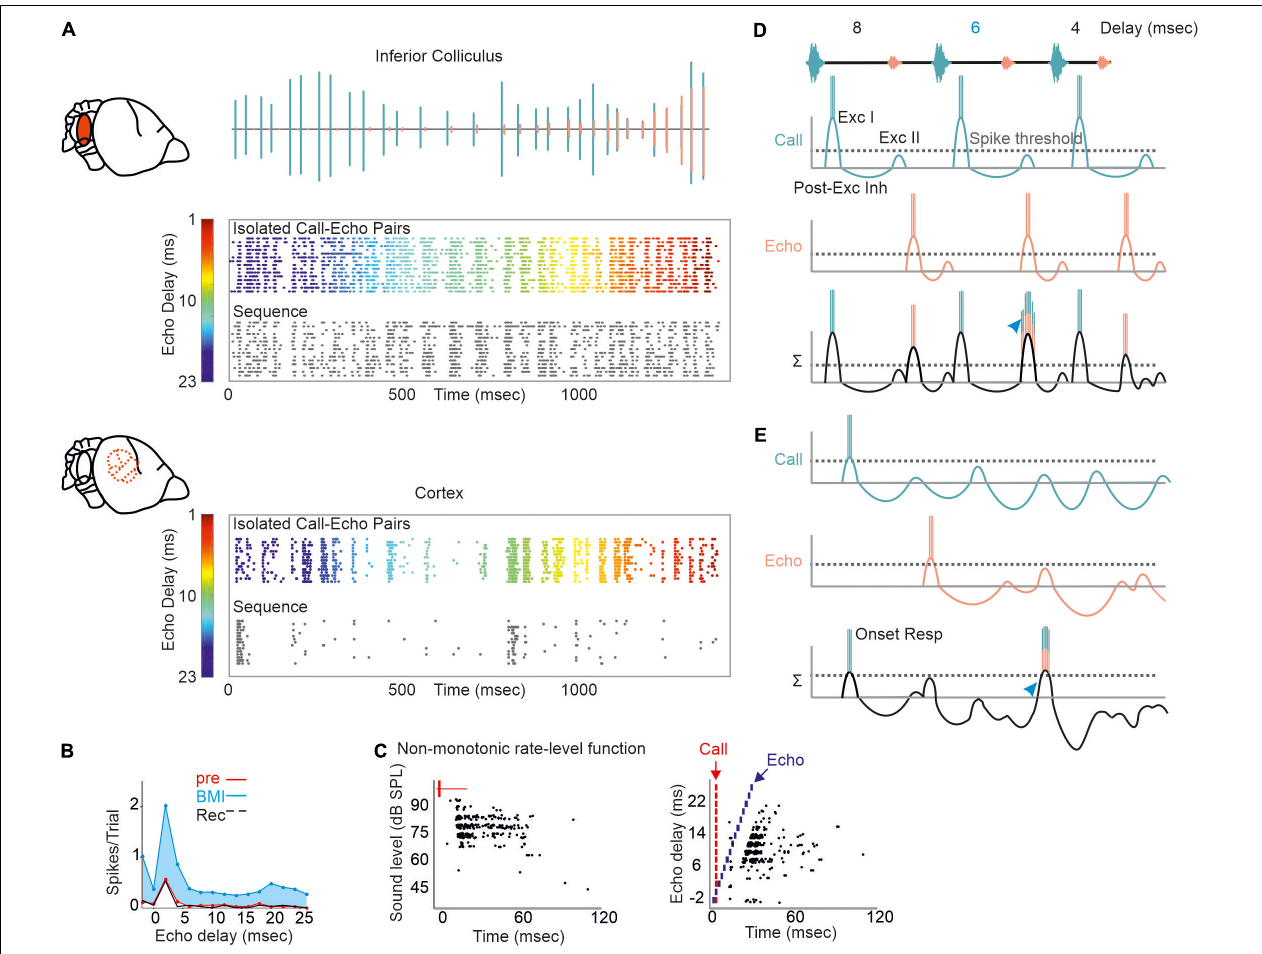
FIGURE 5 | Proposed mechanism of processing naturalistic echolocation sequences. (A) Neural response to isolated call-echo pairs (colored raster plot) presented in randomized order and with 500 ms interstimulus time-interval and to a naturalistic echolocation sequence (black raster plot) from the inferior colliculus ( upper ) and auditory cortex ( lower ) of C. perspicillata . The naturalistic echolocation sequence is shown as oscillogram where green and orange events indicate calls and echoes, respectively. (B) Effect of GABA blocking in a cortical delay-tuned neuron. Blockage with bicuculline methiodide (BMI) reduces the spike rate while the delay-tuning was unaffected. (C) Rate-level function ( left ) and delay tuning ( right ) visualized as raster plots of one cortical neuron. Note that the neuron responds non-monotonically with more spikes to faint than to intense sound levels ( left ). Each black dot represents a spike. (D,E) Proposed models of processing echolocation sequences in the inferior colliculus (D) and auditory cortex (E) . For simplicity, the synaptic input to delay-tuned neurons is demonstrated for a sequence containing three call-echo pairs with echo-delays of 8, 6, and 4 ms. Synaptic inputs evoked by calls and echoes are indicated in green and orange. Both inputs are linearly summed ( (cid:54) ) to explain the post-synaptic potential and spike output of the delay-tuned neurons. Although, responding with spikes to each acoustic event, the collicular neuron shows a faciliatory response [blue arrowhead in (D) ] to the call-echo pair in which the echo follows the call by 6 ms. The cortical neuron responds more selectively to the 6 ms call-echo pair of the sequence (blue arrowhead). Respectively, data shown in (A–C) are adapted from Hechavarría and Kössl (2014) and Beetz et al.